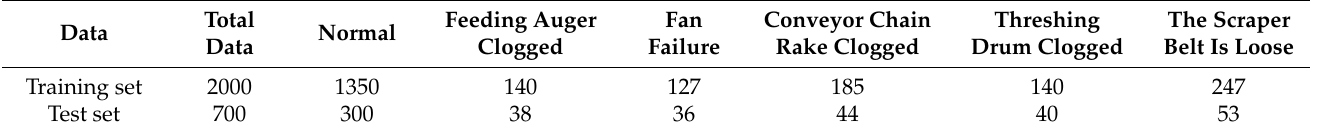
Table 2. The distribution of the number of training and test sets.